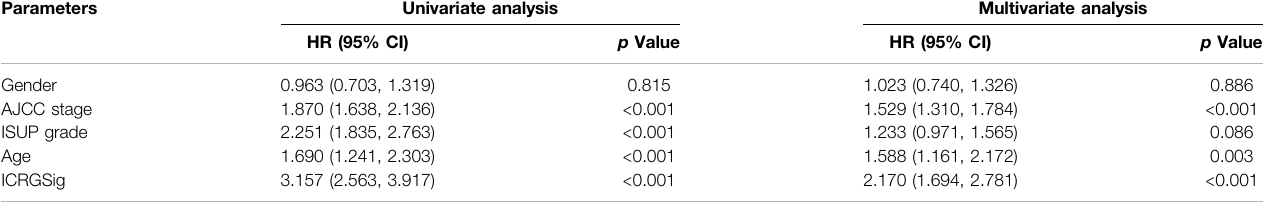
TABLE 3 | Univariate and multivariate Cox analyses of clinical parameters and risk signatures. Parameters